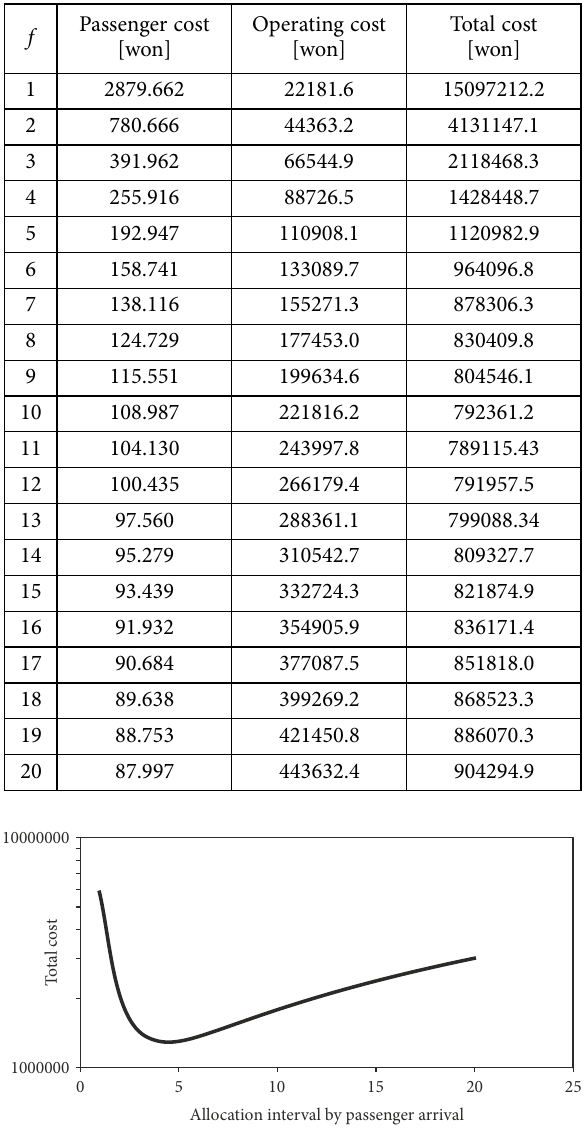
Figure 8. Total cost by allocation interval by passenger